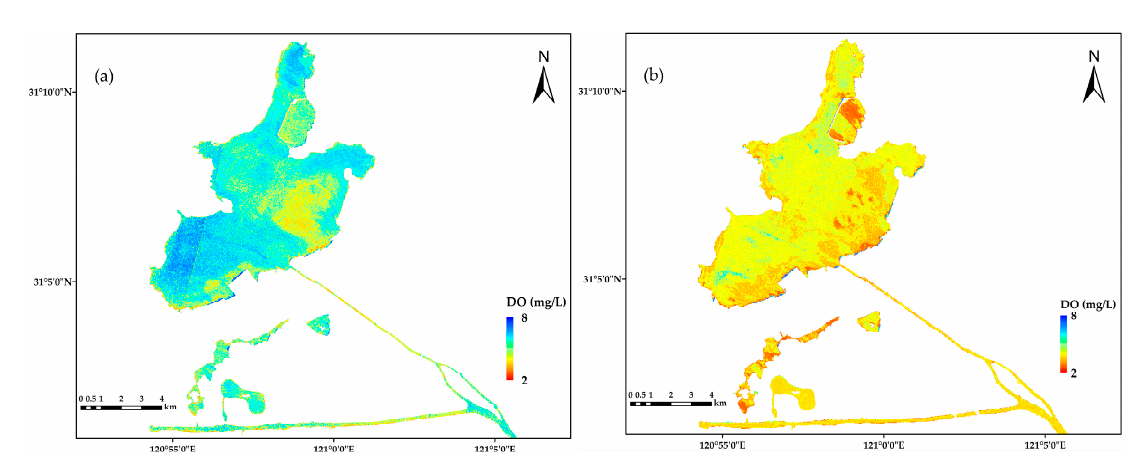
12 of 18 Figure 11. Comparison between AHSI 𝑅 (cid:3045)(cid:3046) -derived and in situ DO ( a ), COD Mn ( b ), and TP ( c ).